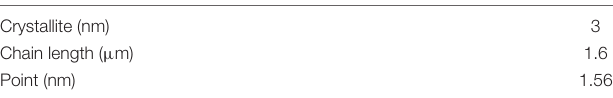
TABLE 3 | Crystallite size and chain parameters of exopolysaccharide from S. commune. Crystallite